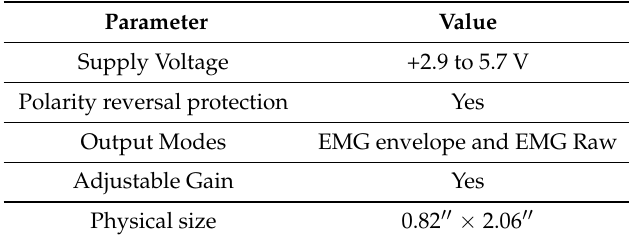
Table 2. Specifications of the Myoware EMG